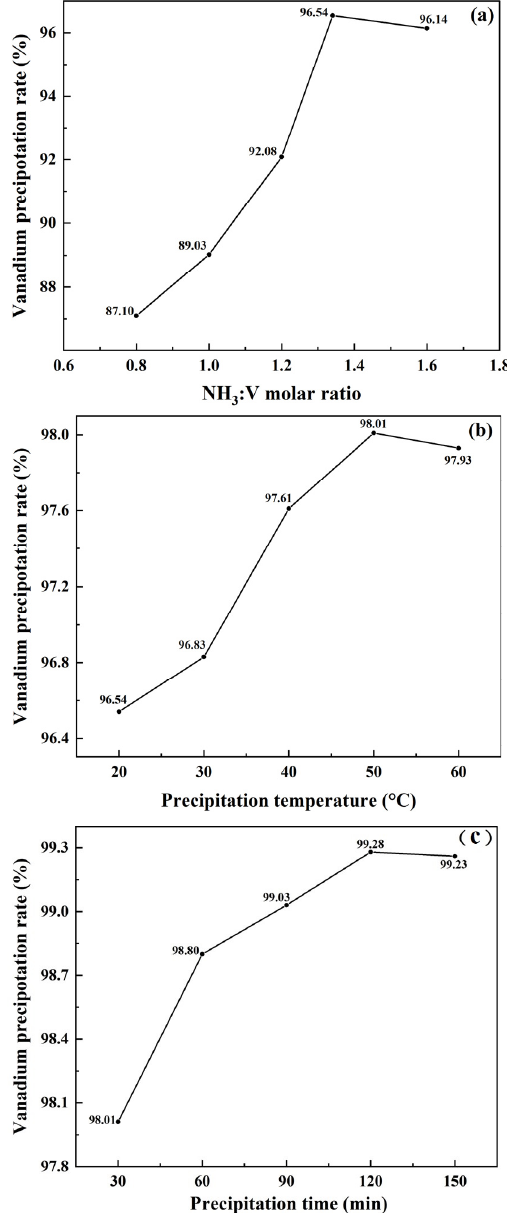
Figure 12. Effects of ( a ) the NH 3 :V molar ratio, ( b ) precipitation temperature, and ( c ) precipitation time on the vanadium precipitation rate.